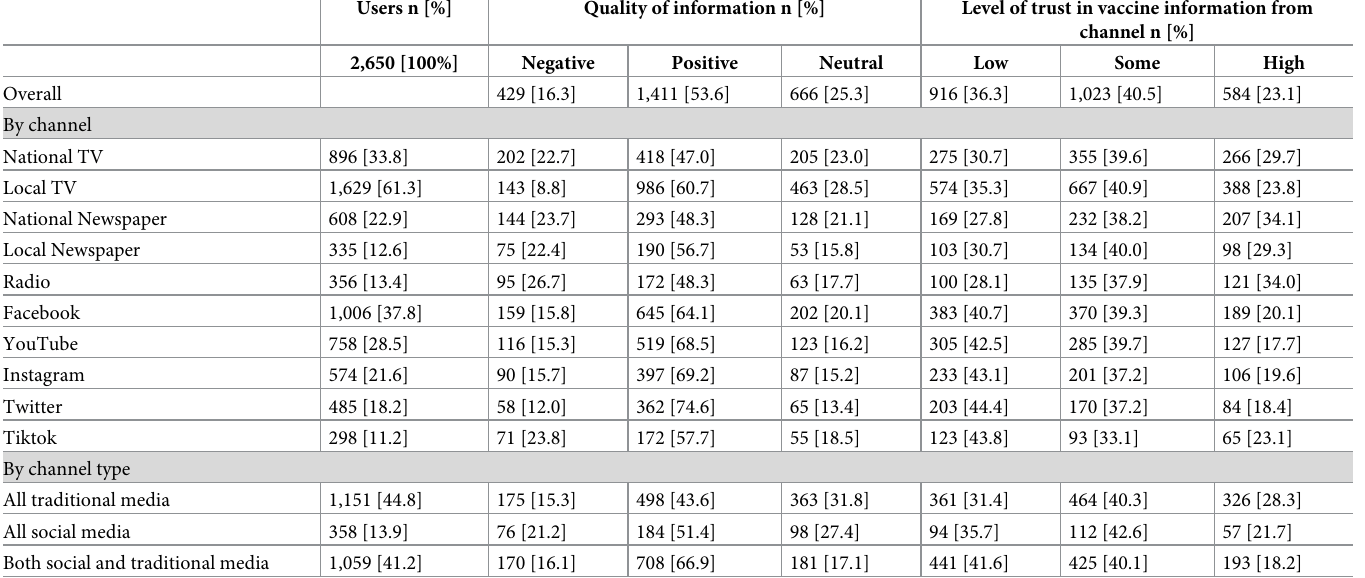
Table 1. Description of COVID-19 information from different